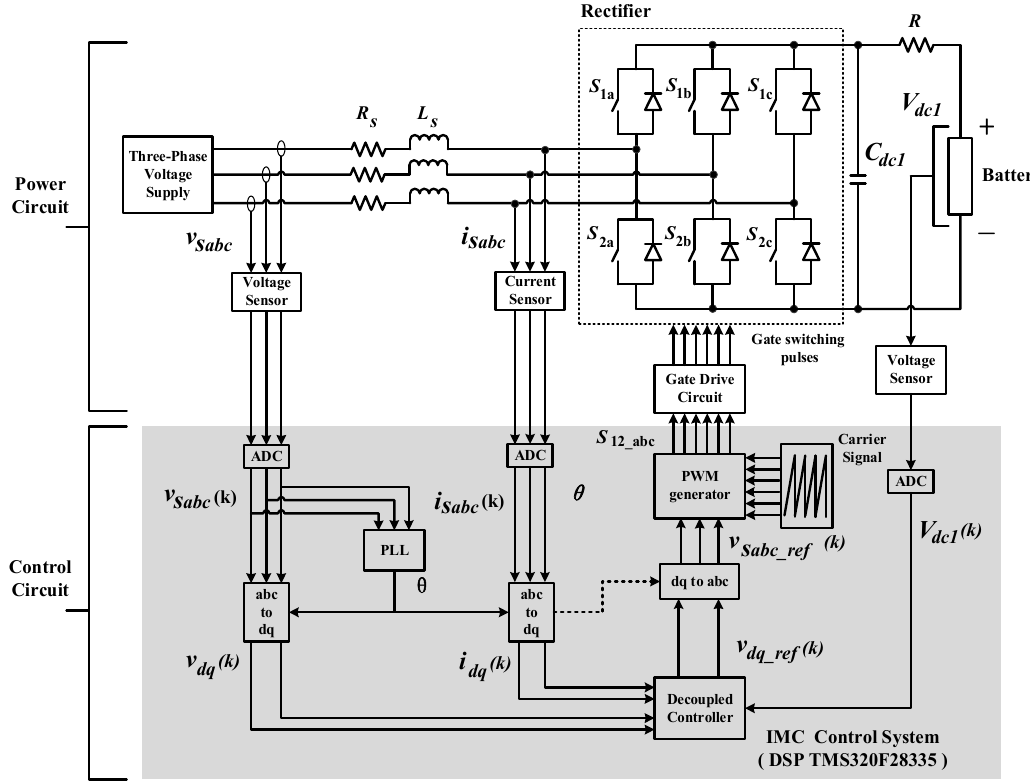
Figure 2. Block diagram of internal model controller (IMC) with synchronized decoupled controller.